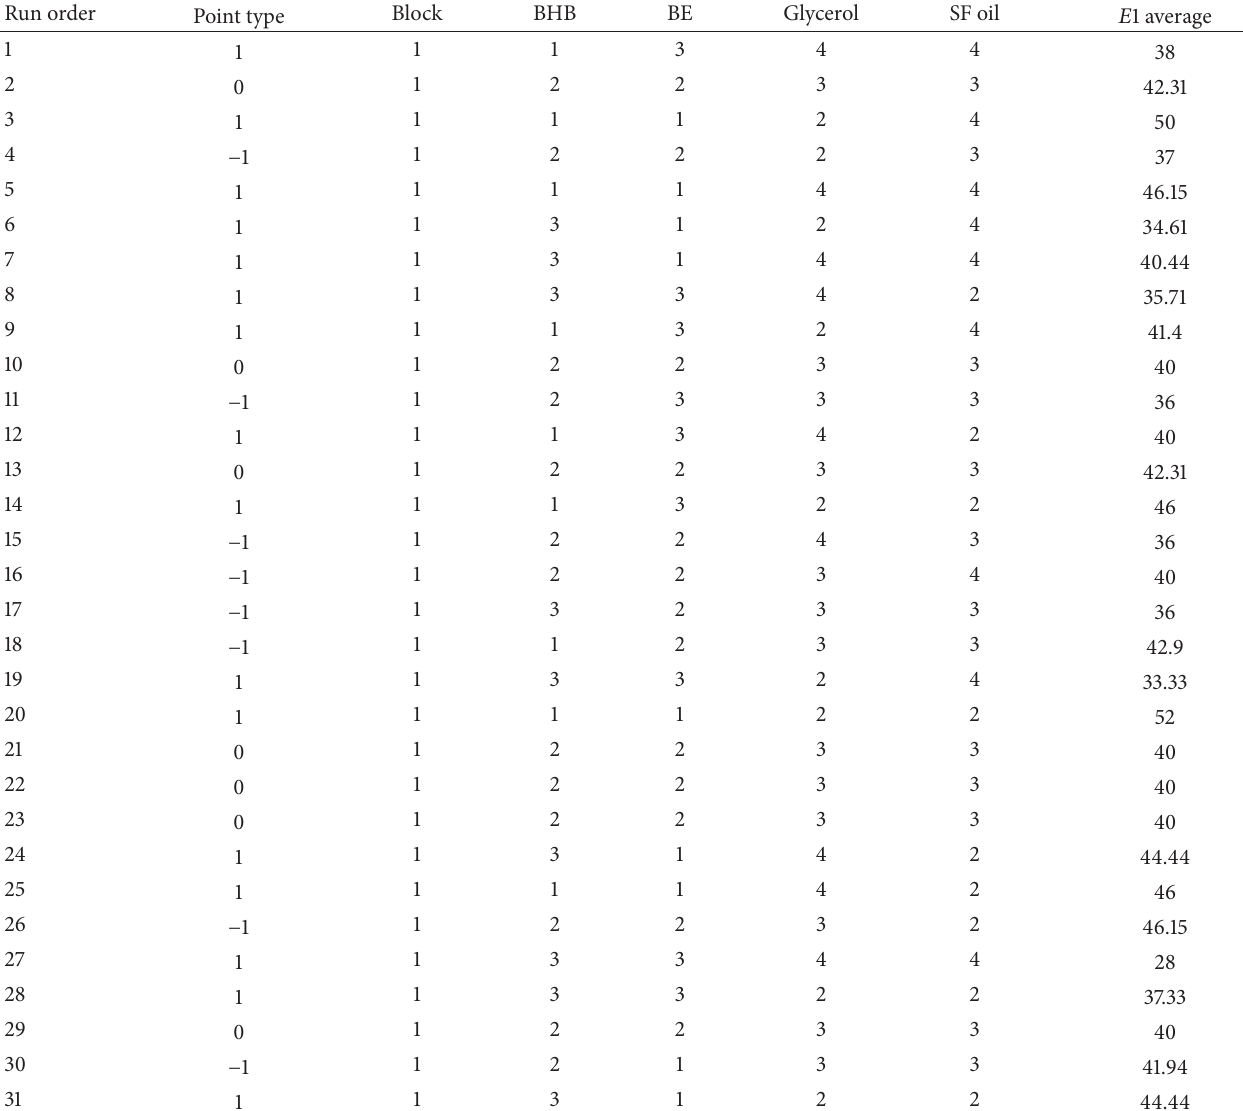
Table 2: Experimental design—RSM for media